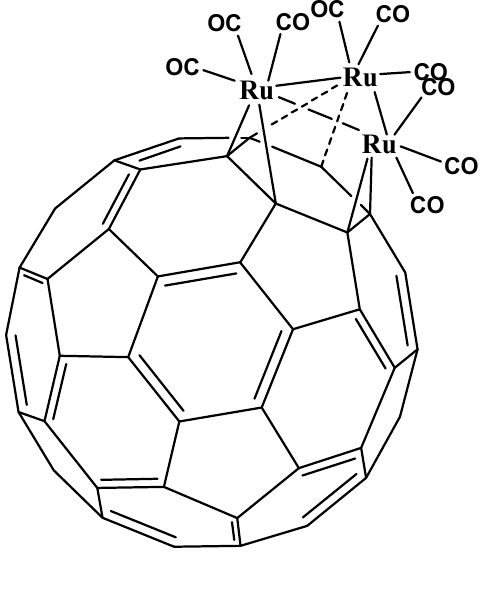
Figure 5. A complex with several η 2 substitutions in one face